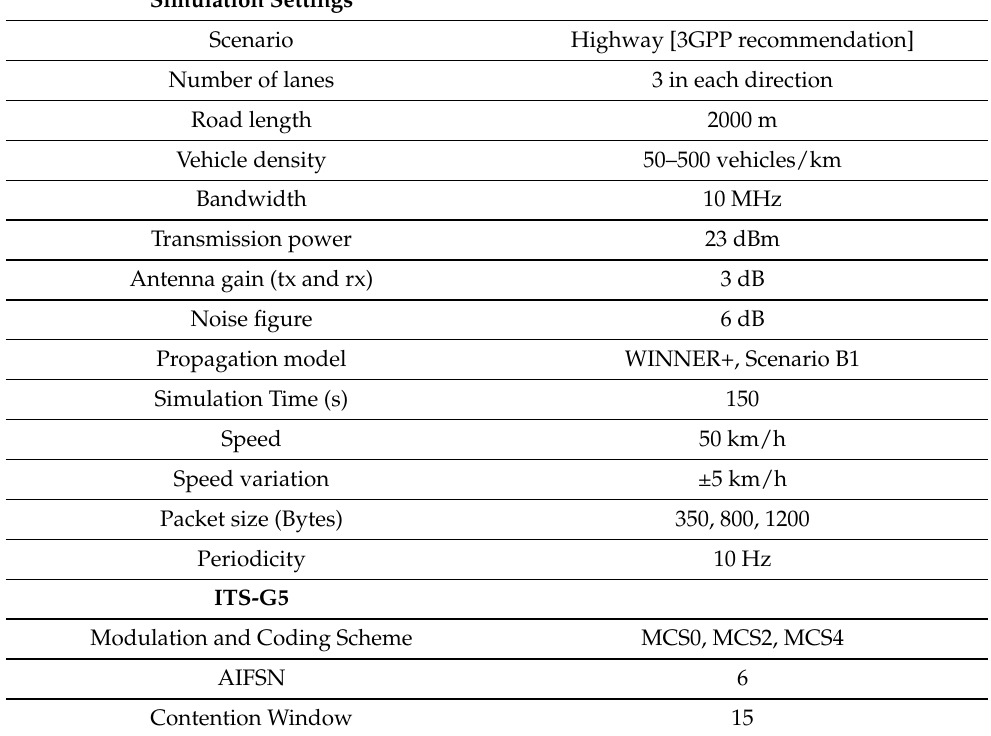
Table 4. Simulation